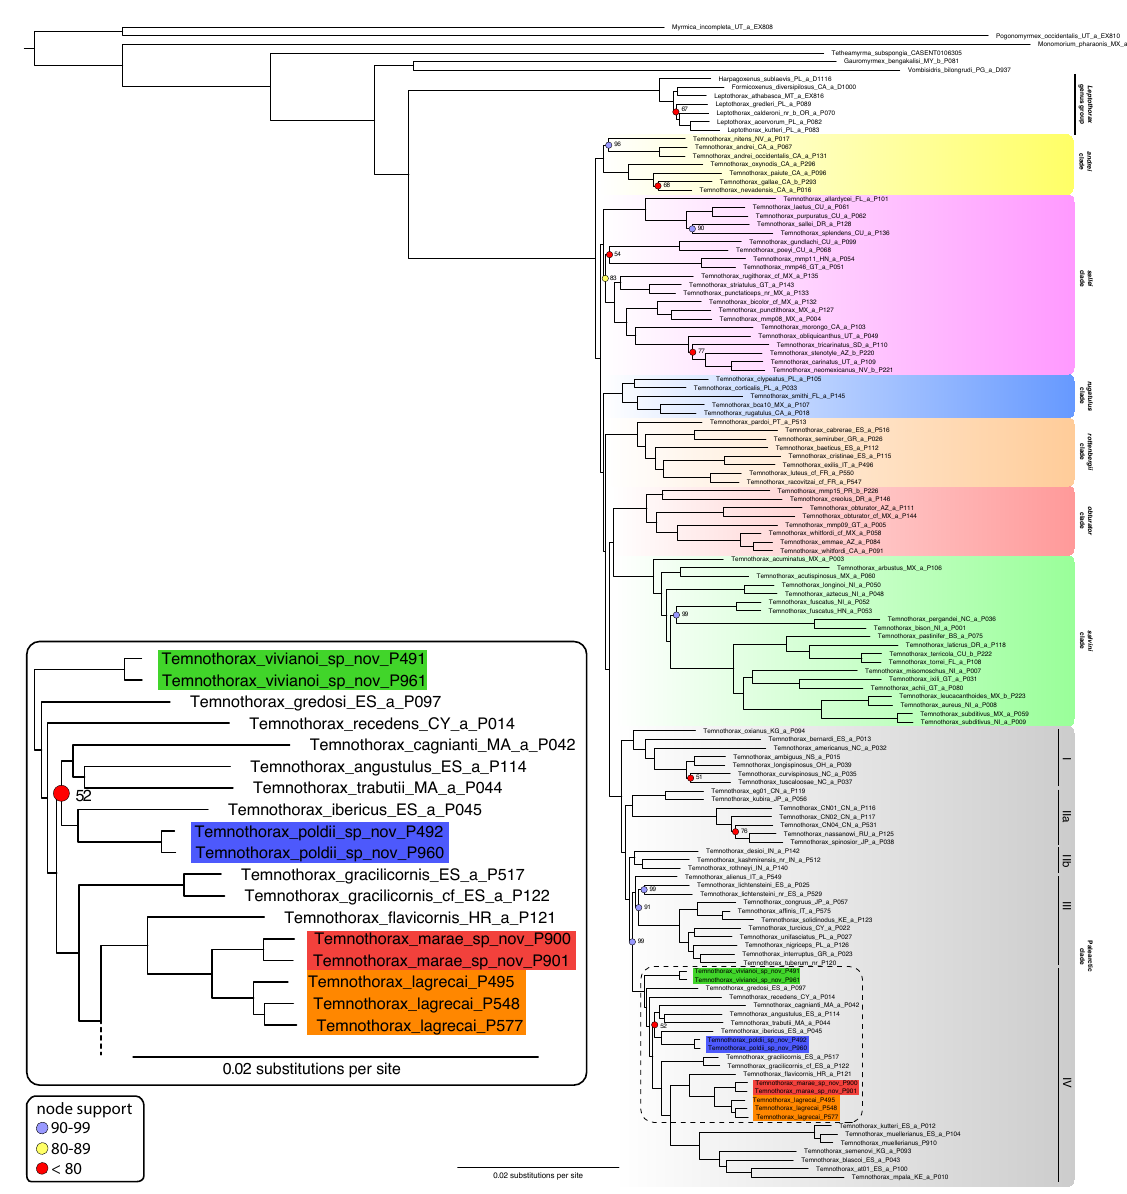
Fig. 79. Maximum likelihood phylogeny inferred with IQTREE ver. 2.1.2. The major clades found in Prebus (2017) are highlighted, and the focal species of the current study (all within the ‘Palearctic clade IV’) are evidenced as in Figs 75 – 78. Maximum likelihood bootstrap support for all nodes are 100, except where